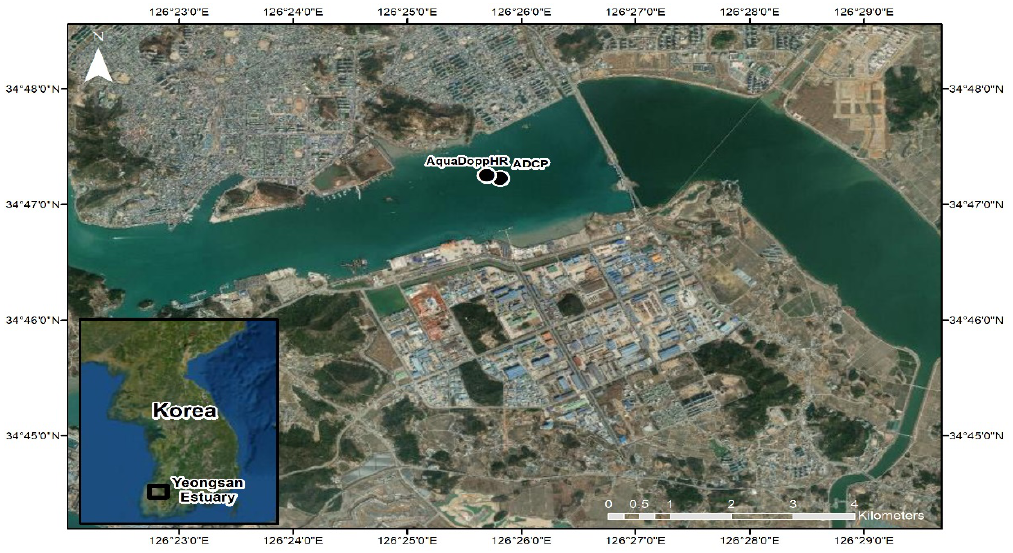
Figure 1. Study area and location of current meters in Yeongsan estuary, Korea. Black dots mark the location of two current meters placed in August 2011.